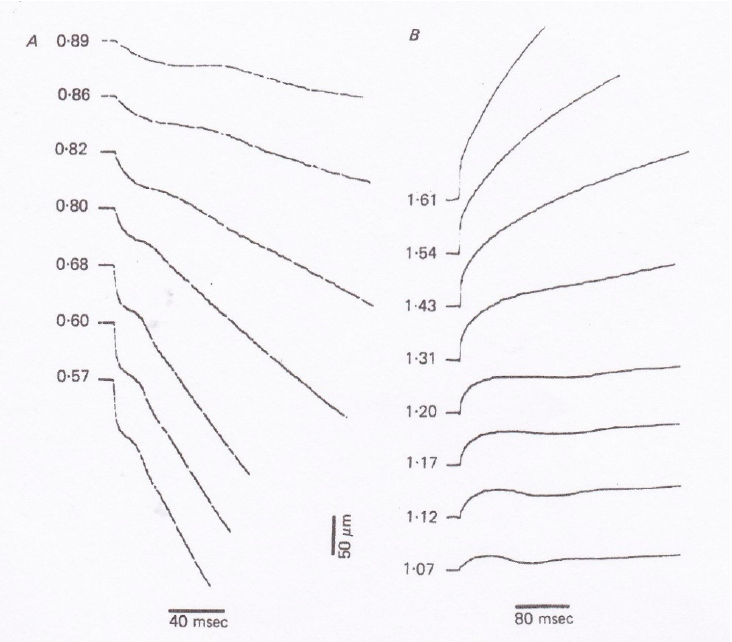
Figure 7. Isotonic velocity transients following quick changes in load from ( A ) Po to P < Po and ( B ) Po to P > Po in tetanized intact single muscle fibers. The values of P are expressed relative to Po on the left of each record. From Ref. [12].